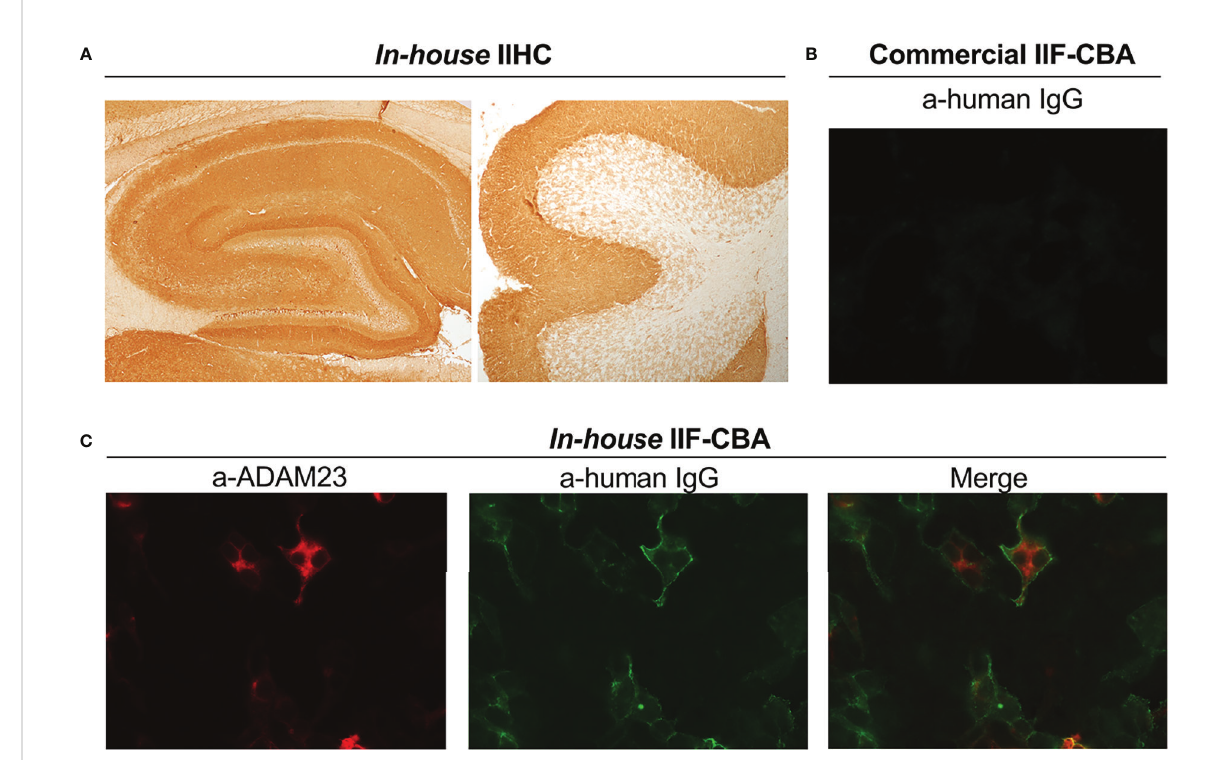
FIGURE 1 LGI1 antibody detection using different tests. (A) Patient ’ s CSF showing LGI1 immunoreactivity with rat brain tissue (IIHC), including hippocampus (left) and cerebellum (right). (B) Image showing the lack of reactivity of the patient ’ s CSF with HEK293 cells expressing LGI1 (commercial indirect immuno fl uorescent cell based assay) (C) In-house IIF-CBA show the reactivity of the same sample with HEK293 cells co- expressing LGI1 and ADAM23: Left, expression of ADAM23 con fi rmed with a commercial antibody (a-ADAM23); Middle, reactivity of patient ’ s antibodies with LGI1; Right, merge. Patient ’ s CSF did not react with HEK293 cells expressing only ADAM23 (not shown). IIF-CBA: indirect immuno fl uorescent cell based assay; ADAM23: disintegrin and metalloproteinase domain-containing protein